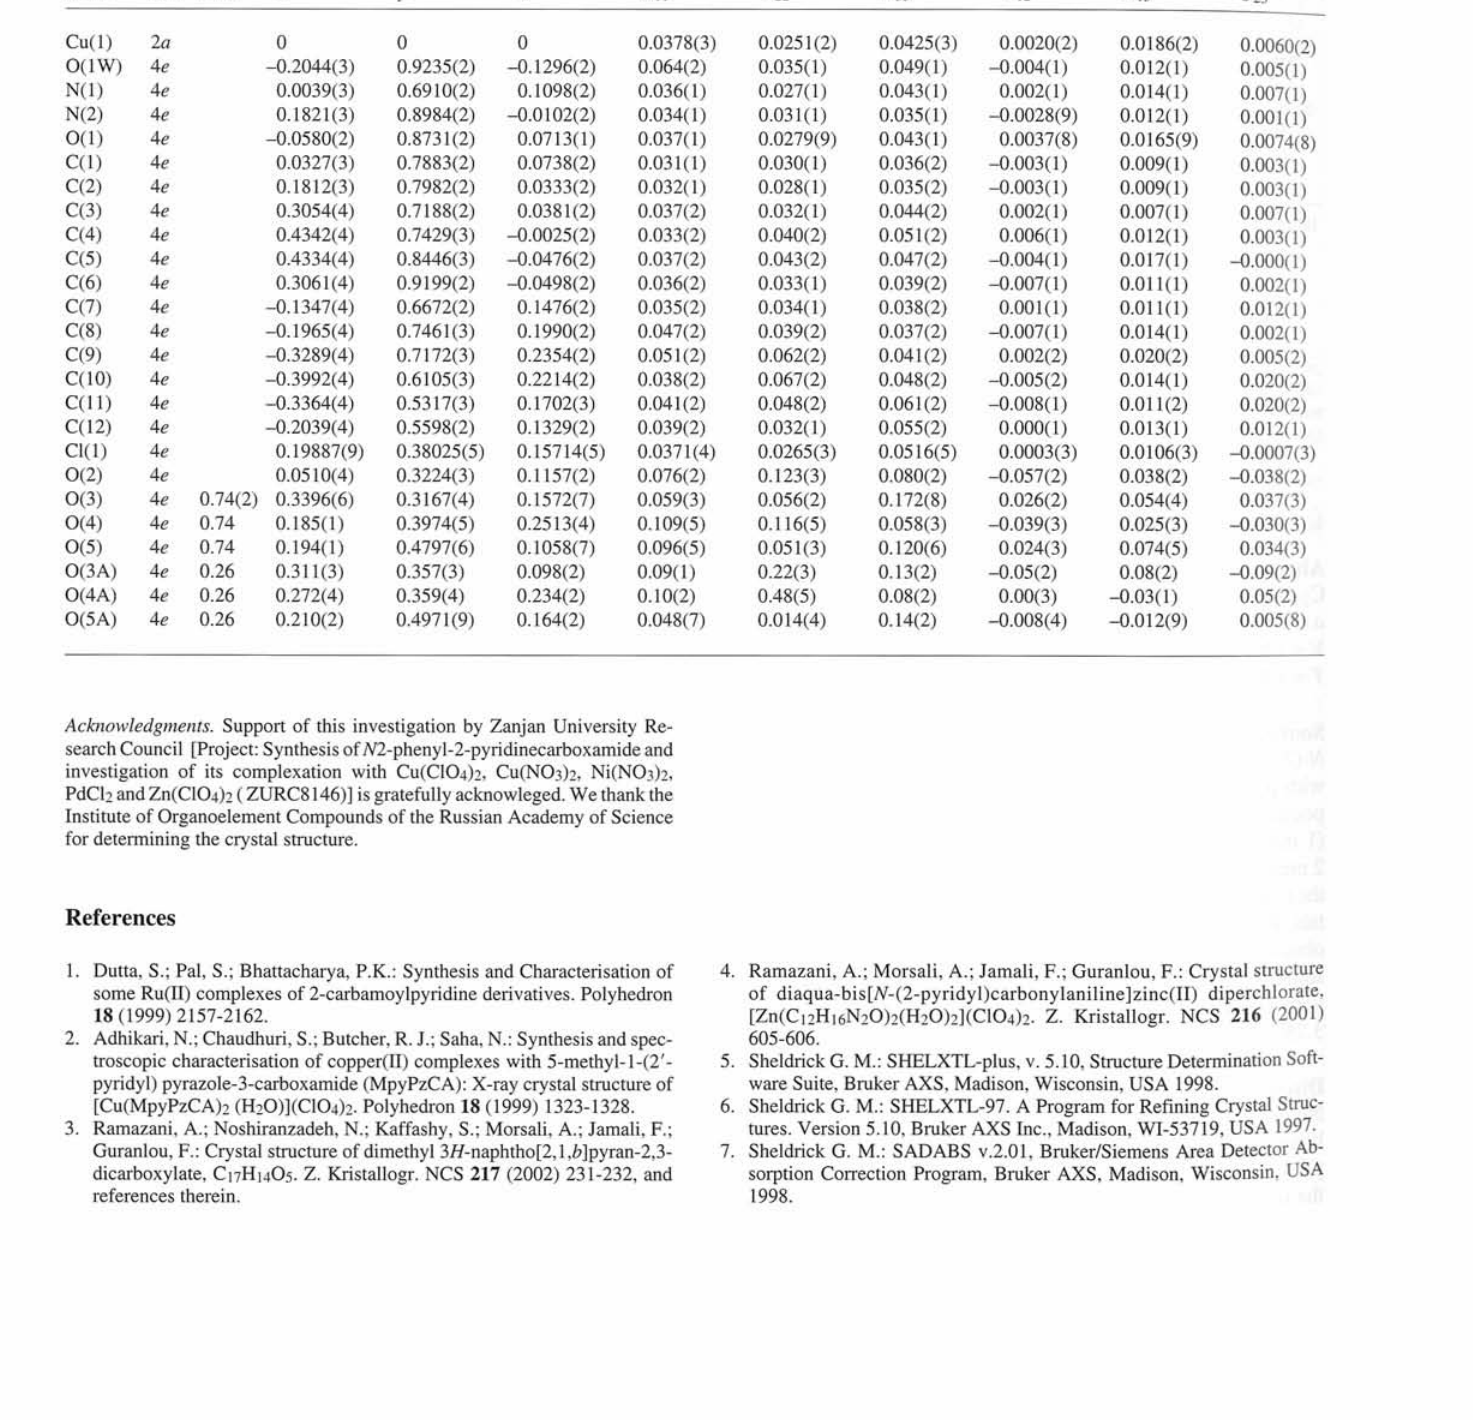
Table 3. Atomic coordinates and displacement parameters (in Â 2 ). Atom Site